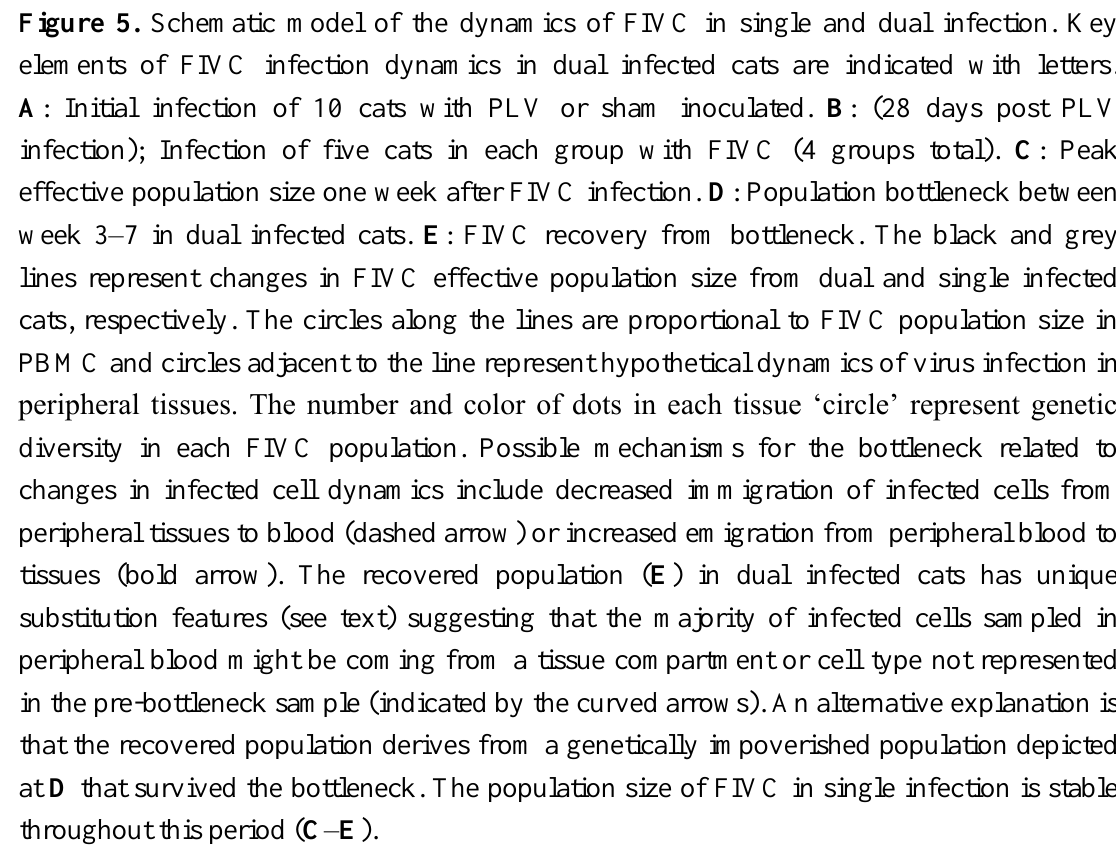
Figure 5. Schematic model of the dynamics of FIVC in single and dual infection. Key elements of FIVC infection dynamics in dual infected cats are indicated with